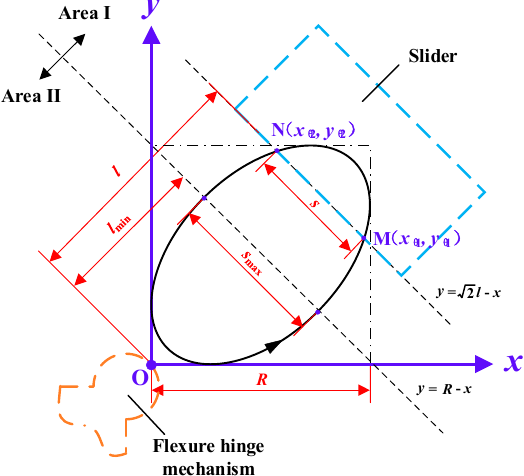
Figure 9. Relationship between the output range of the flexure hinge mechanism and the single-step displacement of the